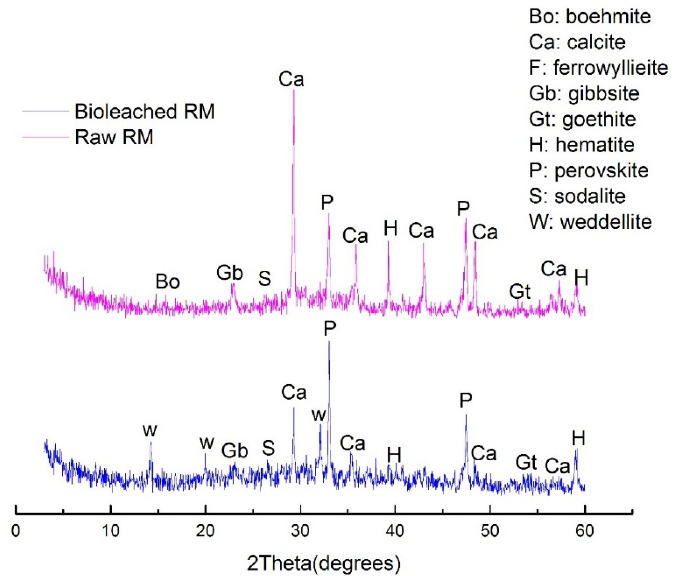
Figure 5. XRD analysis of raw and bioleached RM.